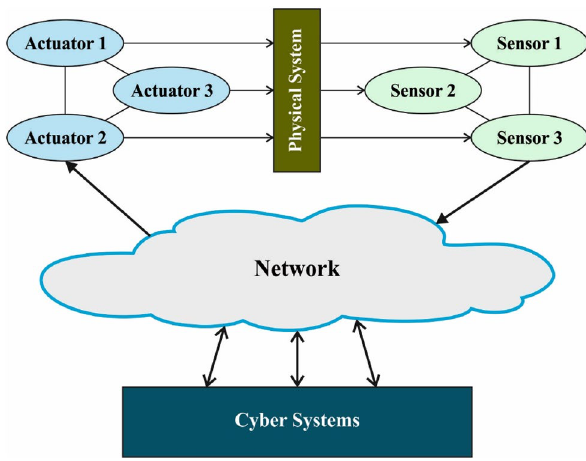
Figure 2. System architecture of CPS.